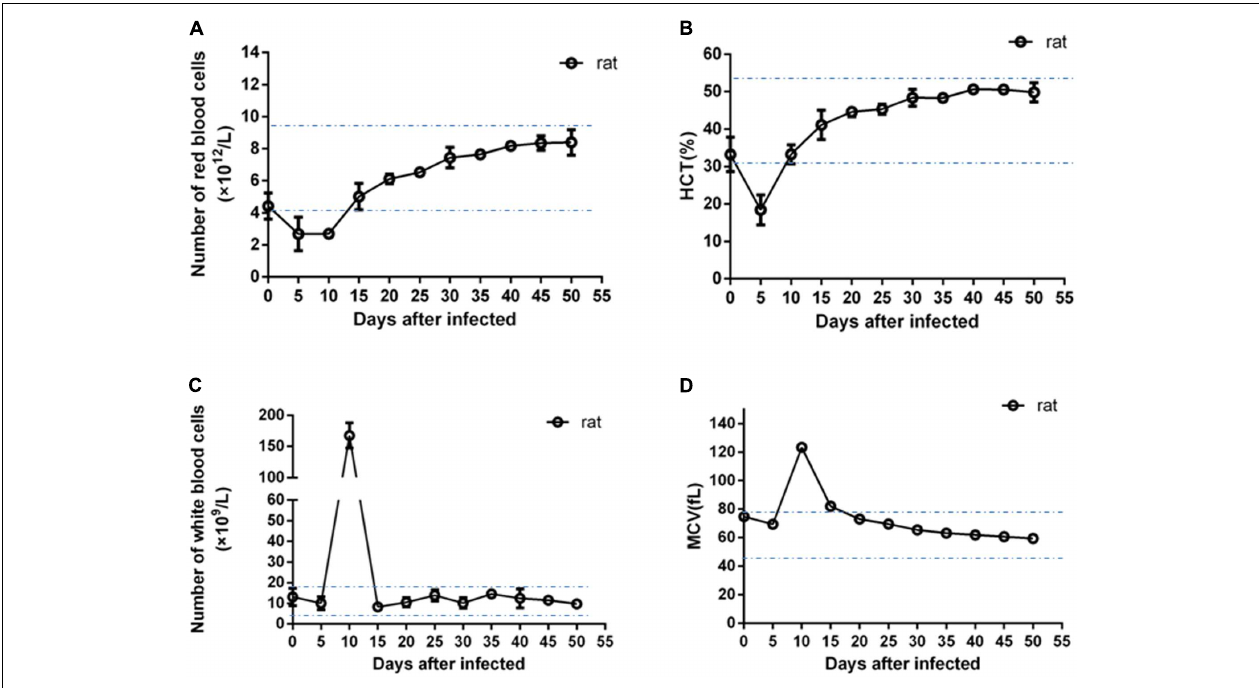
FIGURE 2 | Blood examination of the infected rats. The error bars represent three biological replicates. The dotted lines showed the minimum and maximum values of normal ranges. (A) Values of number of red blood cells; (B) values of hematocrit (HCT); (C) values of number of white blood cells; (D) values of mean corpuscular volume (MCV).